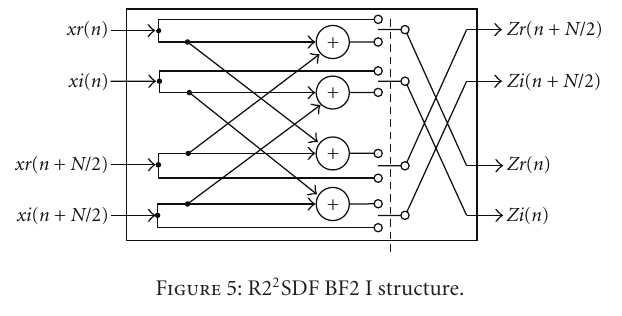
Figure 5: R2 2 SDF BF2 I structure.